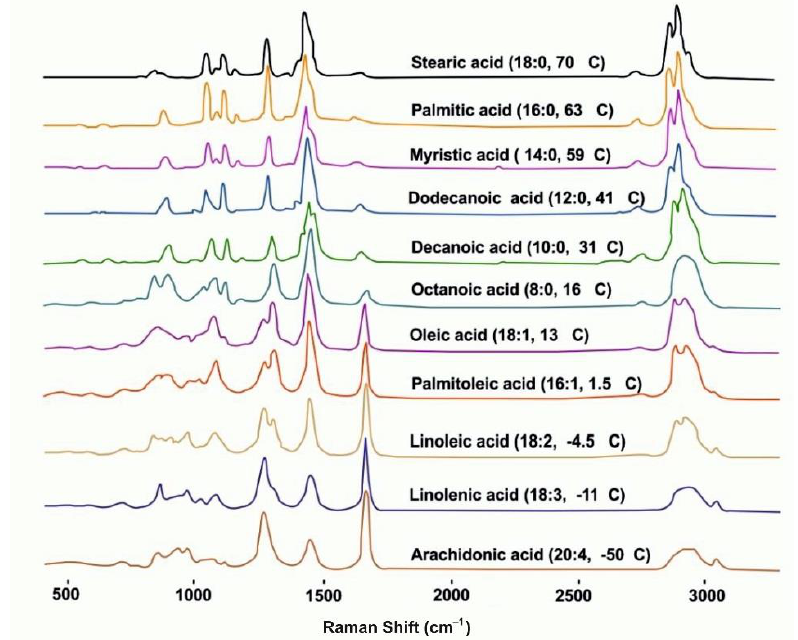
Figure 6. Raman spectra of various lipid molecules of Botryococcus braunii [23].